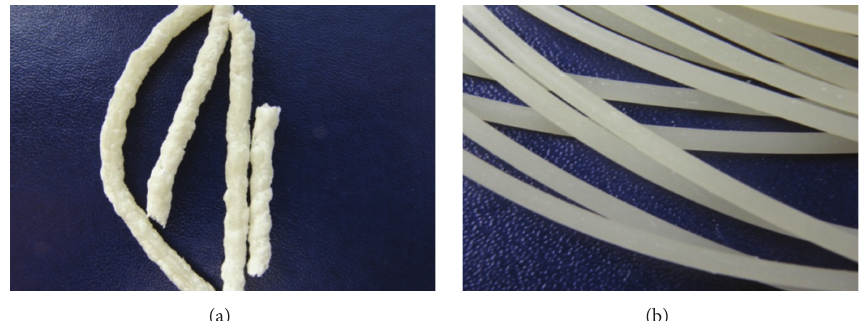
Figure 10: The dependence of the extrudate surface appearance (extrusion at 155 ∘ C and 10 kg load) on the plasticizing level ((a) 27%; (b)